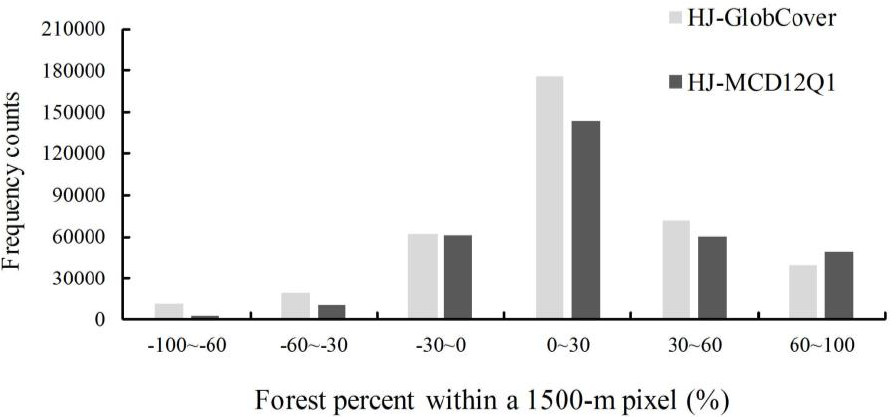
Figure 10. Pixel frequency at various levels of percentage difference between HJ-1 2010 and GlobCover 2009, HJ-1 2010 and MCD12Q1 2009.